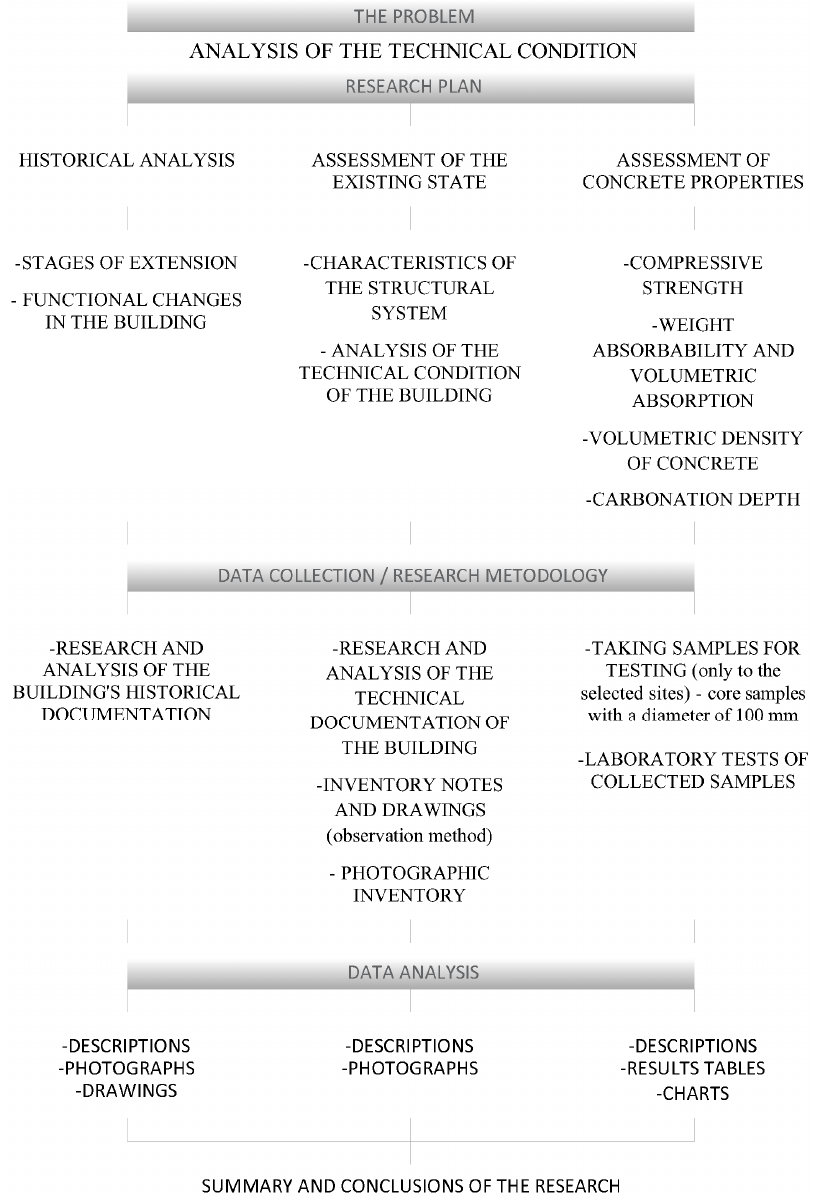
Figure 1. Diagram of the research process.